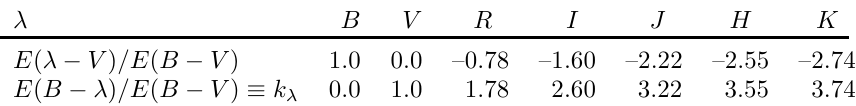
Table 1. The Rieke & Lebofsky (1985) extinction law. λ B V R I J H K E ( λ − V ) /E ( B − V